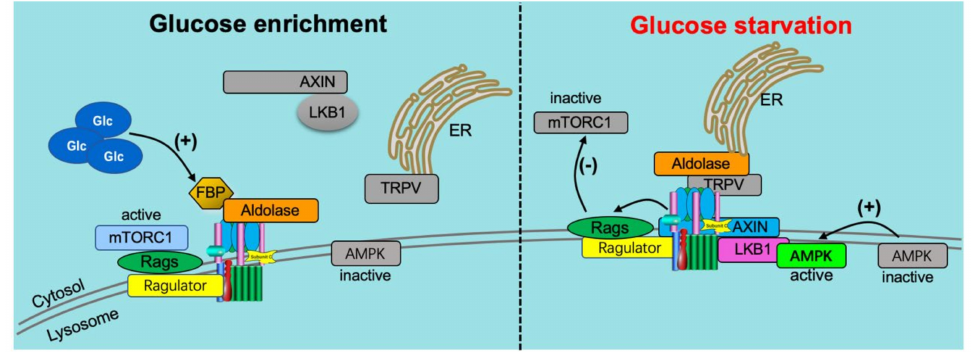
Figure 4. v-ATPase-dependent glucose signaling. (1) When glucose is enriched ( left panel ), it activates the ragulator complex, which acts as a GEF toward the RagGTPases (Rags), activating them. The Rag GTPases are anchored to the lysosomal membrane by the ragulator complex bound to the v-ATPase. Subsequently, the mammalian target of rapamycin complex 1 (mTORC1) is re- cruited to the lysosomal membrane by the active Rag GTPases, where it can be activated by the lysosomal Rheb GTPases. In addition, when glucose is enriched, the glycolytic intermediate fructose- 1,6-bisphosphate (FBP) binds to the aldolase-v-ATPase complex. (2) Under conditions of glucose starvation ( right panel ), FBP disassociates from aldolase, allowing endoplasmic reticulum (ER)- localized transient receptor potential V-type (TRPV) channels to bind the v-ATPase at the aldolase binding site. FBP-unoccupied aldolase binds and inhibits TRPV Ca2þ channel activity allowing for the recruitment of the AXIN-LKB1 complex to the lysosomal membrane where it interacts with ragulator and inhibits its GEF activity toward Rags causing the disassociation from the lysosome and inactivation of mTORC1. Furthermore, the v-ATPase, AXIN, and LKB1 recruit AMPK to form a